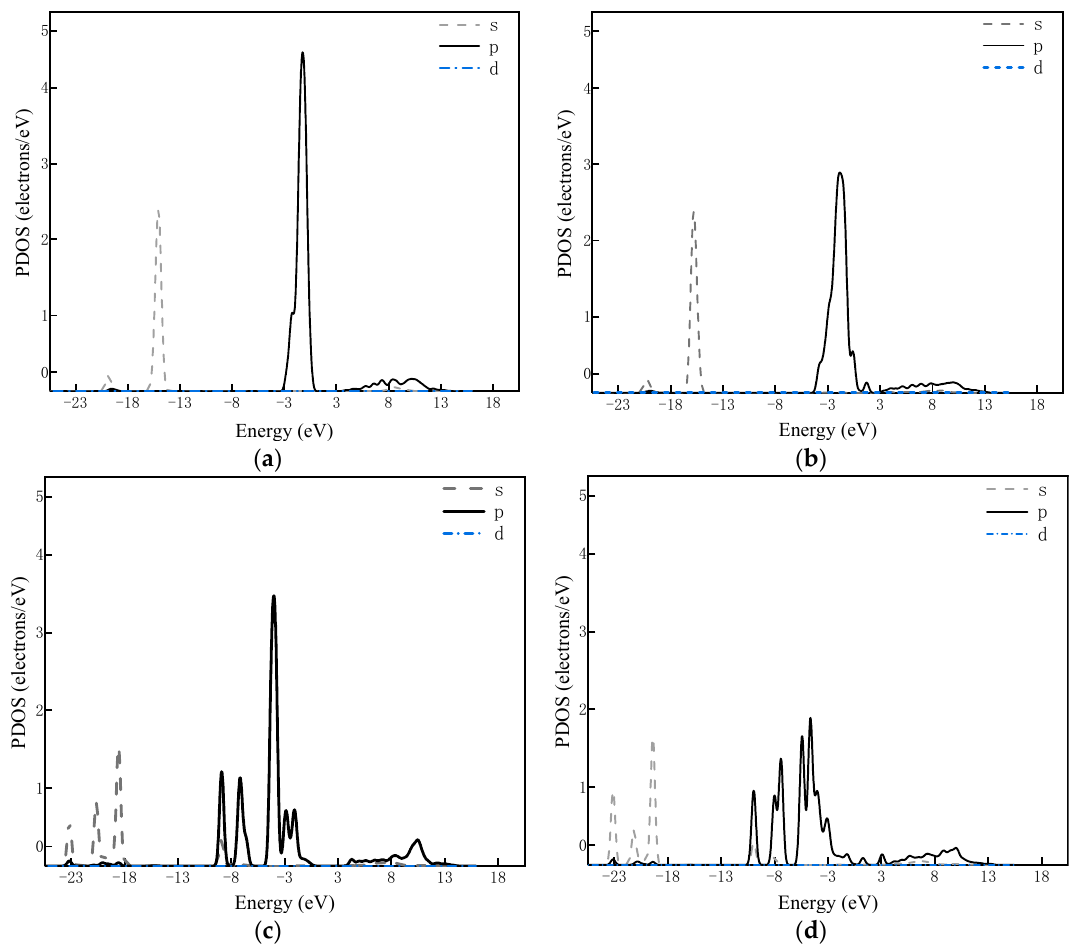
Figure 2. Partial density of states (PDOS) spectra of Osurf atoms s: ( a ) the PDOS of the O surf atom on CaO (100) surface; ( b ) the PDOS of the O surf atom on 10 wt % Ni/CaO (100) surface; ( c ) the PDOS of the O surf atom on CaO (100) surface after CO 2 adsorption; ( d ) the PDOS of the O surf atom on 10 wt % Ni/CaO (100) surface after CO 2 adsorption.